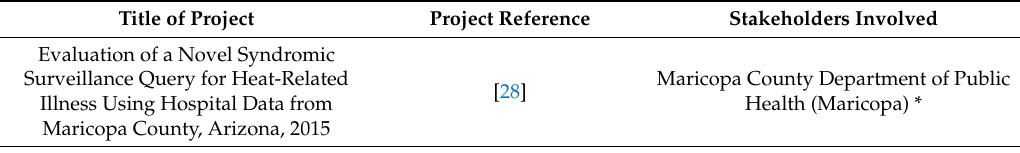
Table 1. Examples of climate and health adaptation work in Arizona. * indicates Lead